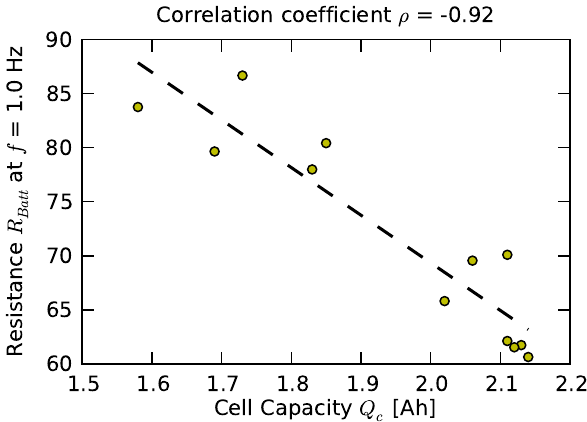
Figure 9. Capacities of individual cells in early life failure scenario.